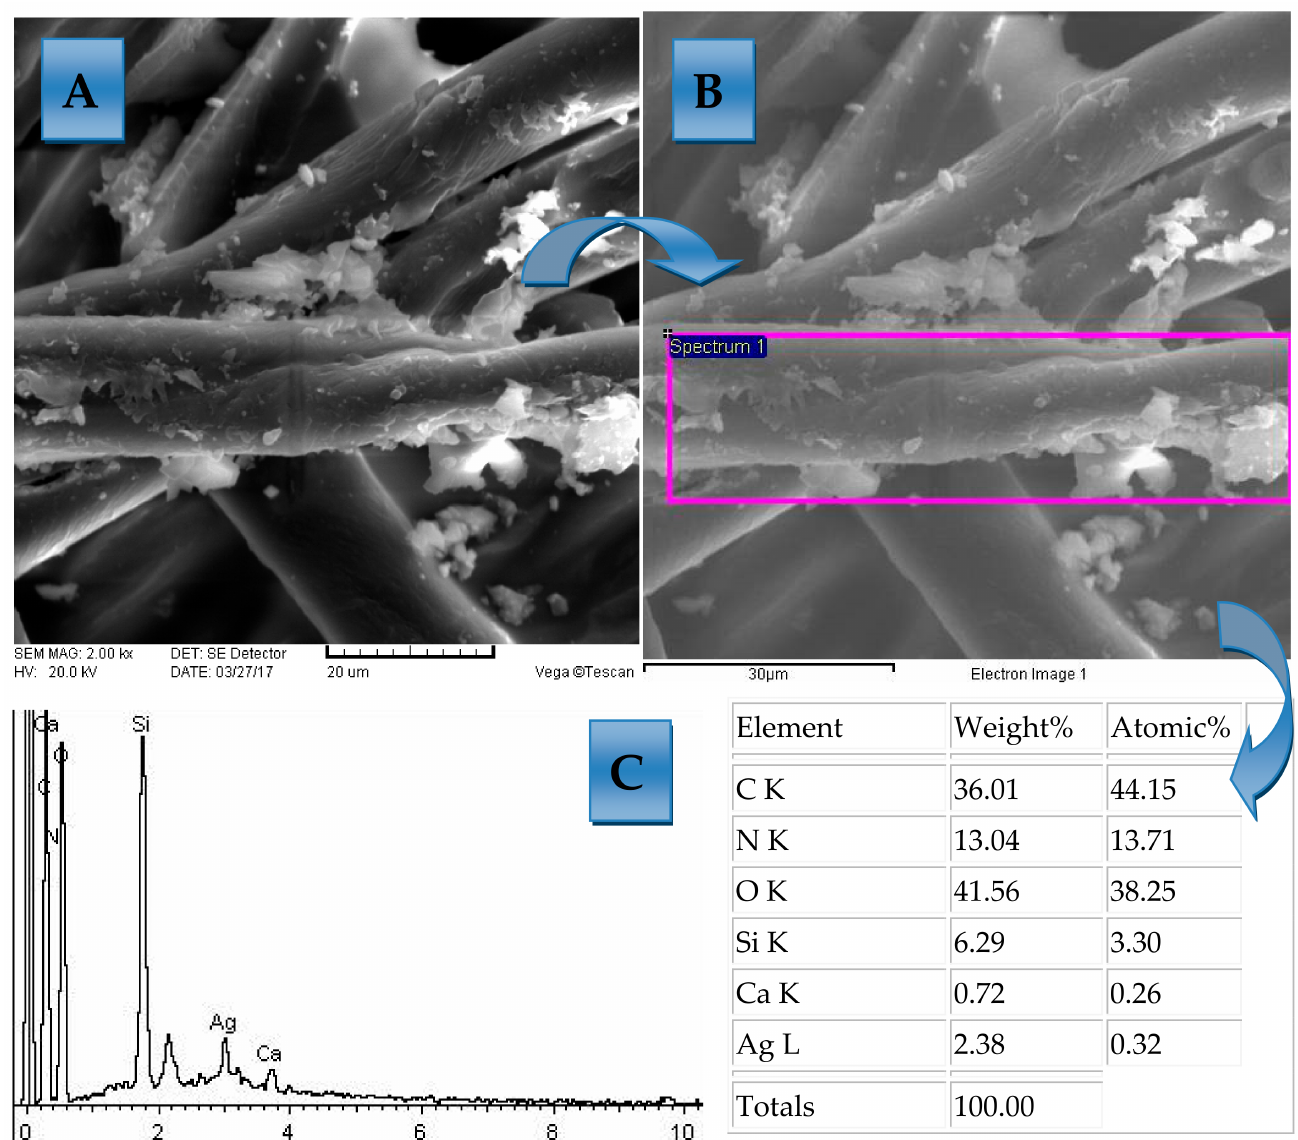
Figure 5. ( A ) SEM microphotograph of AgNPs and homogenous coating layer on polymers ma-terials with specified area used for EDX investigation; ( B ) The purple square is the area that was scanned for mapping; ( C ) Results of the SEM-EDX investigation with the proof that the cellulose material was successfully modified with the Ag coating. Magnification of ( C ) was 1000